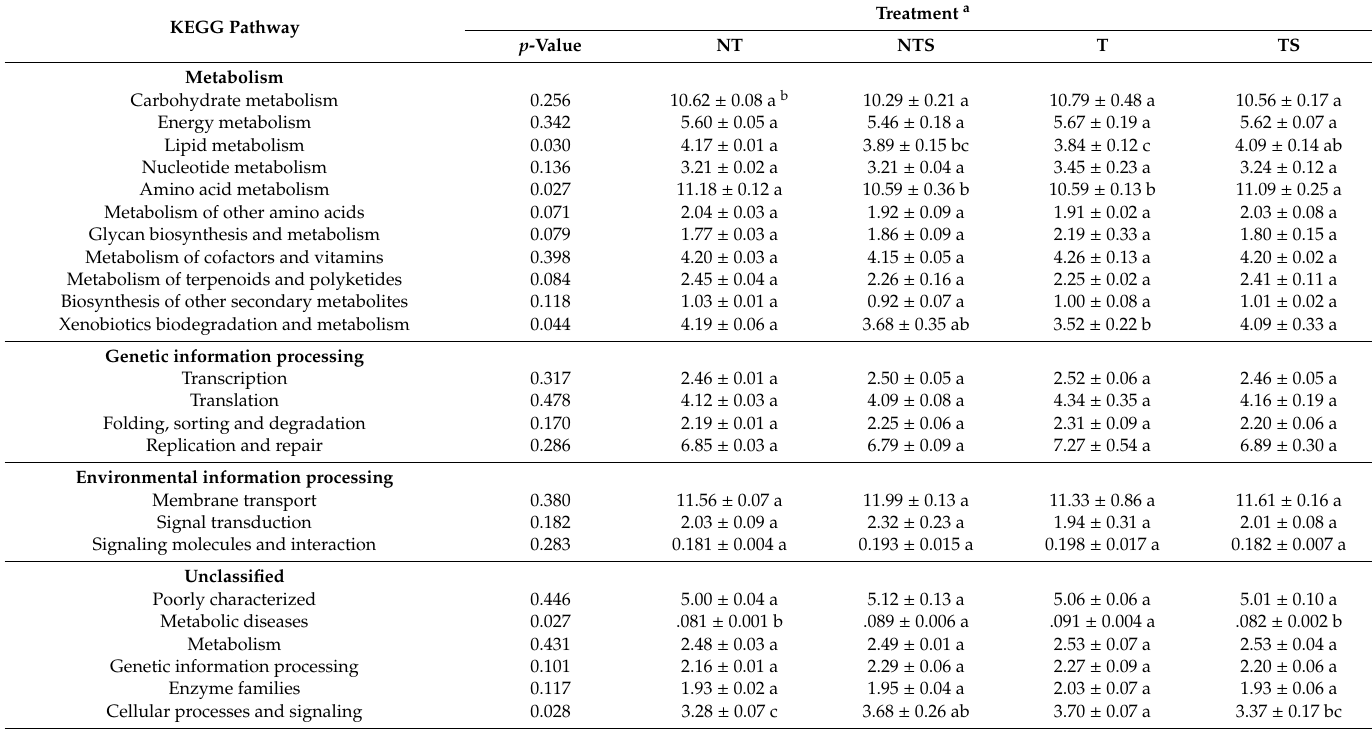
Table 3. Relative abundance of soil bacterial community top four predicted functions related to KEGG pathways at level two as a ff ected by tillage and crop residue management